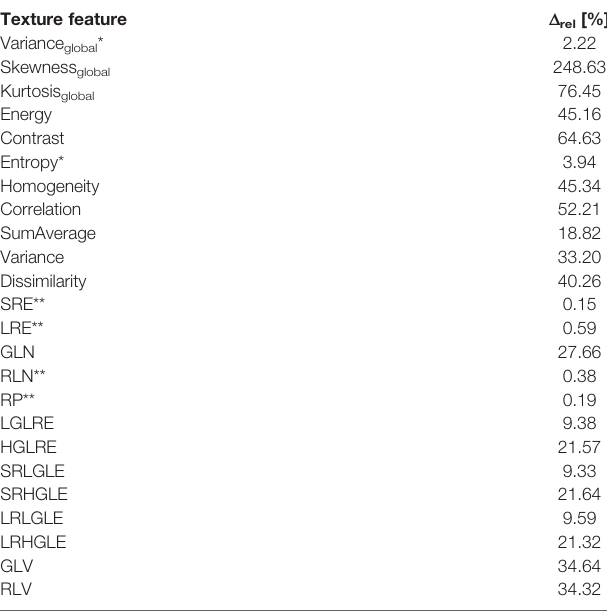
TABLE 2 | Relative difference D rel between baseline and follow-up measurement of the analyzed TFs. Texture